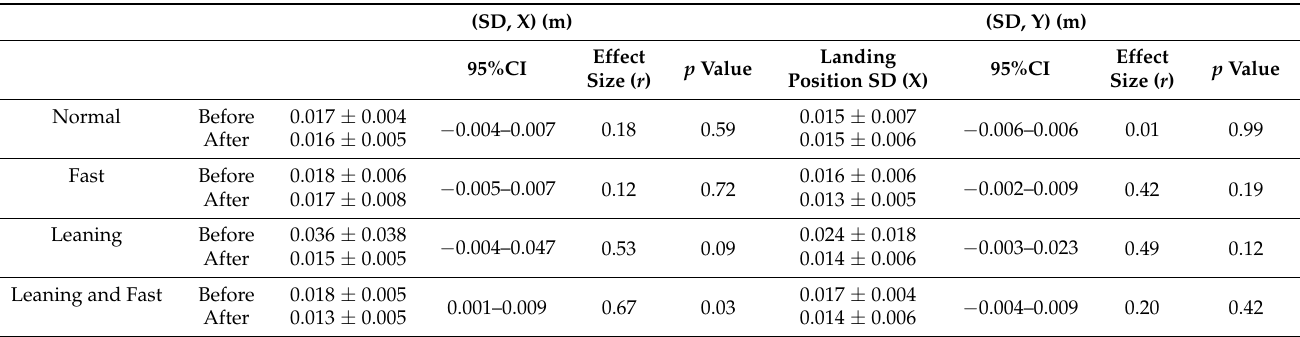
Table 12. Movement variation in the STG in anterior (SD, Y) and lateral (SD, X) direction of G-foot lateral obstacle crossing.